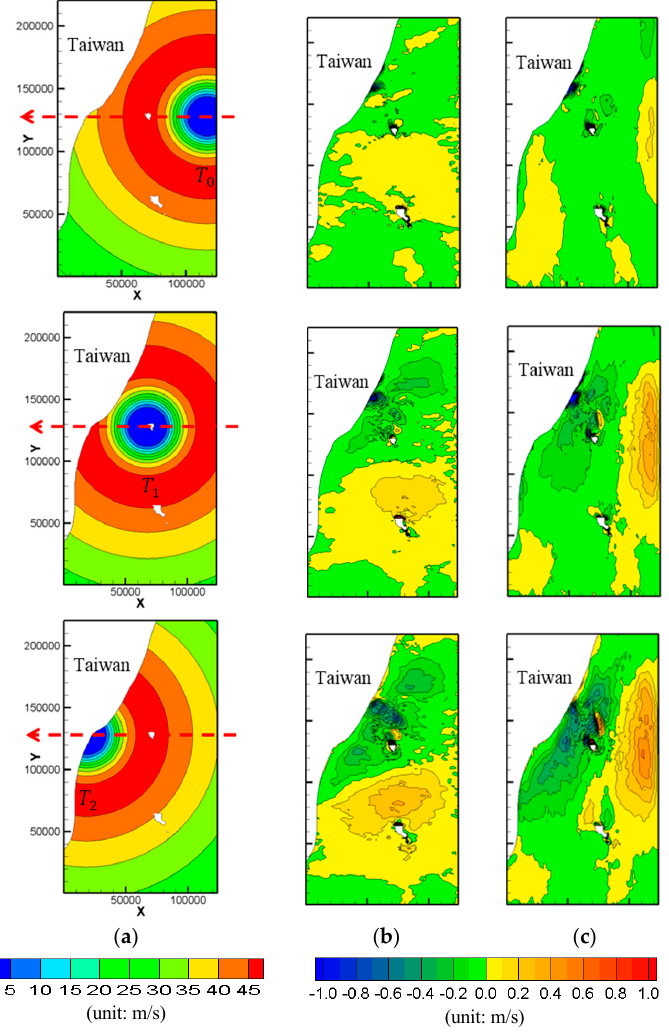
Figure 14. Contours of ( a ) W 10 , “net”( b ) u -, and ( c ) v -contours of (unit: m/s) EW typhoon with moving speed W T = 5.0 m/s at T 0 – T 2 three time instances indicated by the three vertical lines of Figure